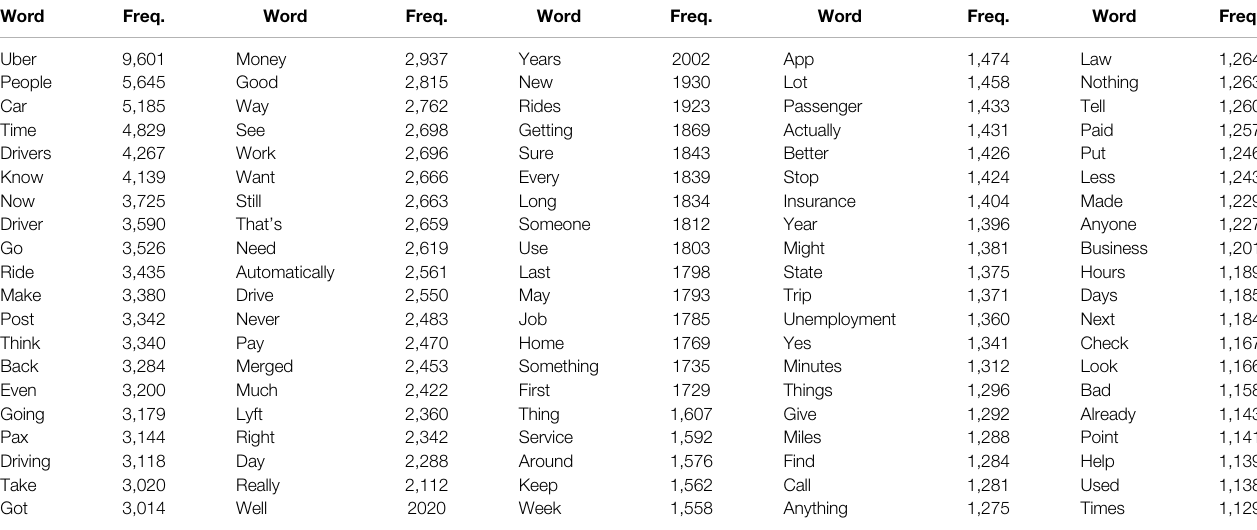
TABLE 3 | Most frequent 100 words of Uber Advice forum. Word